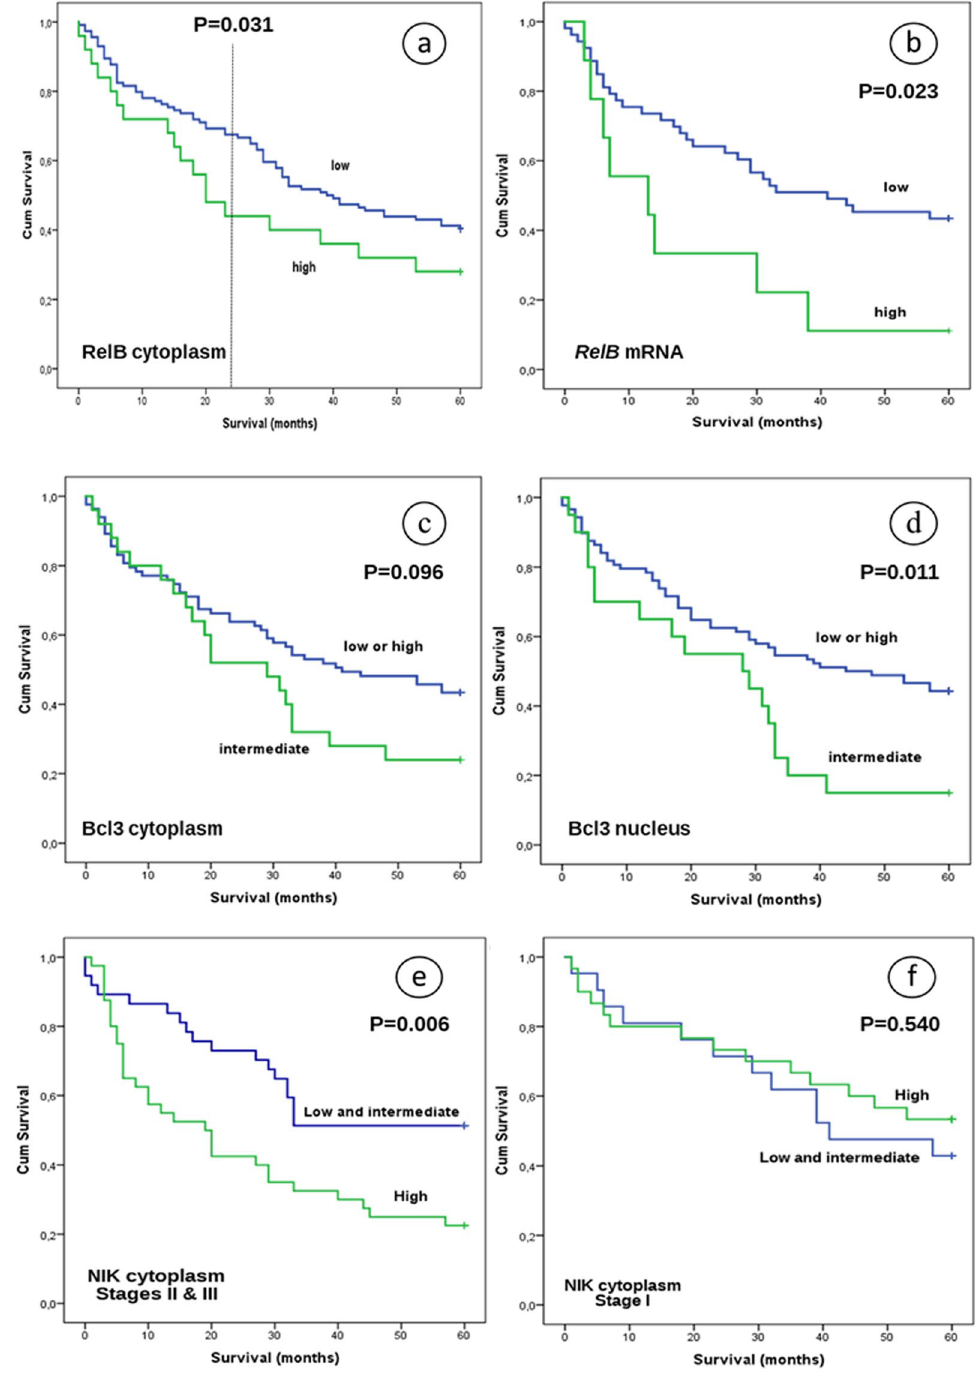
Figure 4. Overall survival of NSCLC patients after 5-year follow-up with regard to ( a ) RelB cytoplasmic signal, ( b ) RelB mRNA expression, ( c ) Bcl3 cytoplasmic protein expression, ( d ) Bcl3 nuclear protein expression, ( e ) NIK cytoplasmic expression of stages II and III patients and ( f ) NIK cytoplasmic expression of stage I